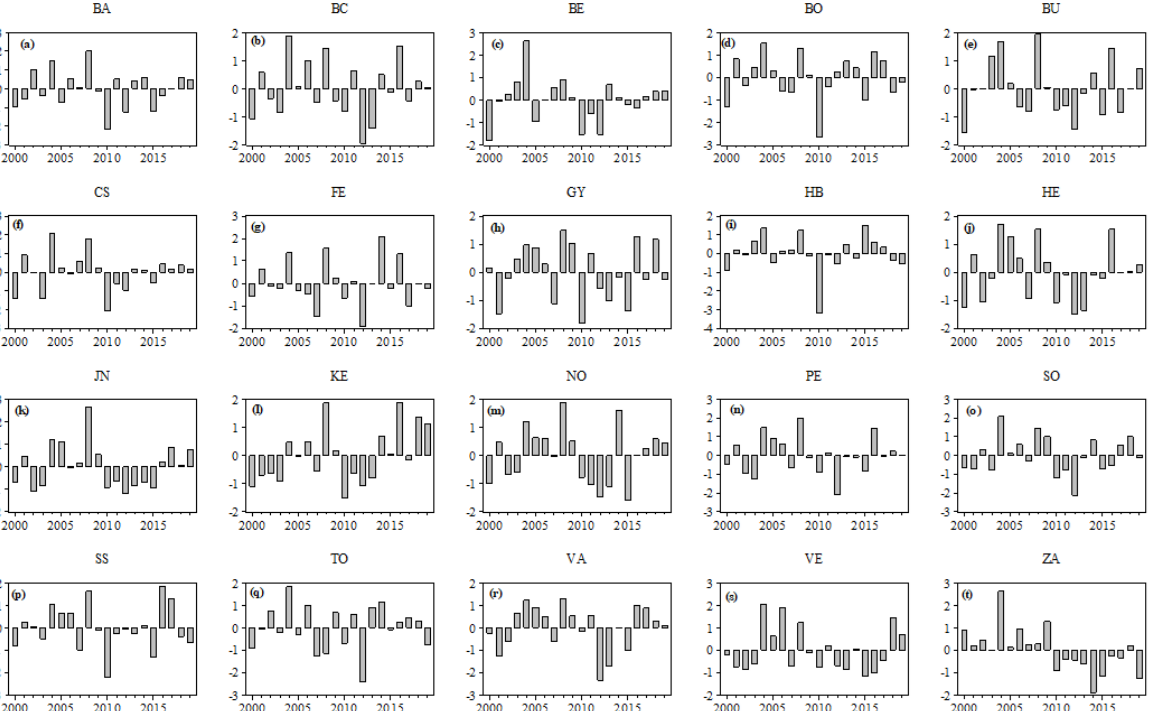
Figure 6. Evolution of SSYR in the studied Hungarian counties (2000–2019). ( a ) BA, ( b ) BC, ( c ) BE, ( d ) BO, ( e ) BU, ( f ) CS, ( g ) FE, ( h ) GY, ( i ) HB, ( j ) HE, ( k ) JN, ( l ) KE, ( m ) NO, ( n ) PE, ( o ) SO, ( p ) SS, ( q ) TO, ( r ) VA, ( s ) VE, ( t ) ZA.